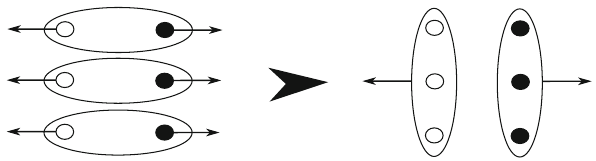
Fig. 4 Measurement of the charged-particle multiplicity at 7TeV with ALICE at LHC [24]. Shown is a comparison of the new colour reconnection model for different reconnection probabilities with the default model of